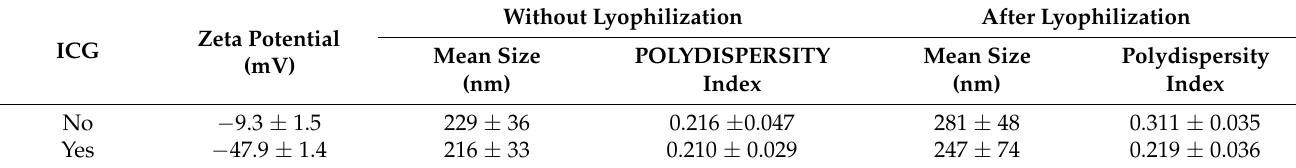
to lyophilization and redispersion as described in the methods section. The data are presented as the mean ± SD ( n =